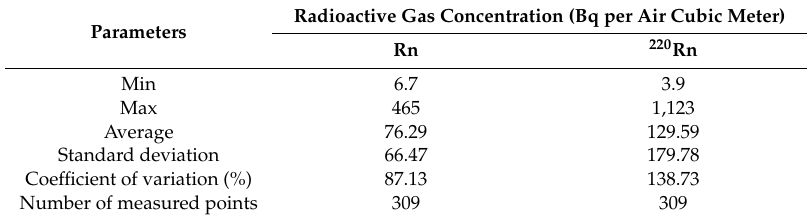
Table 3. Statistic of characterization of radioactive gas